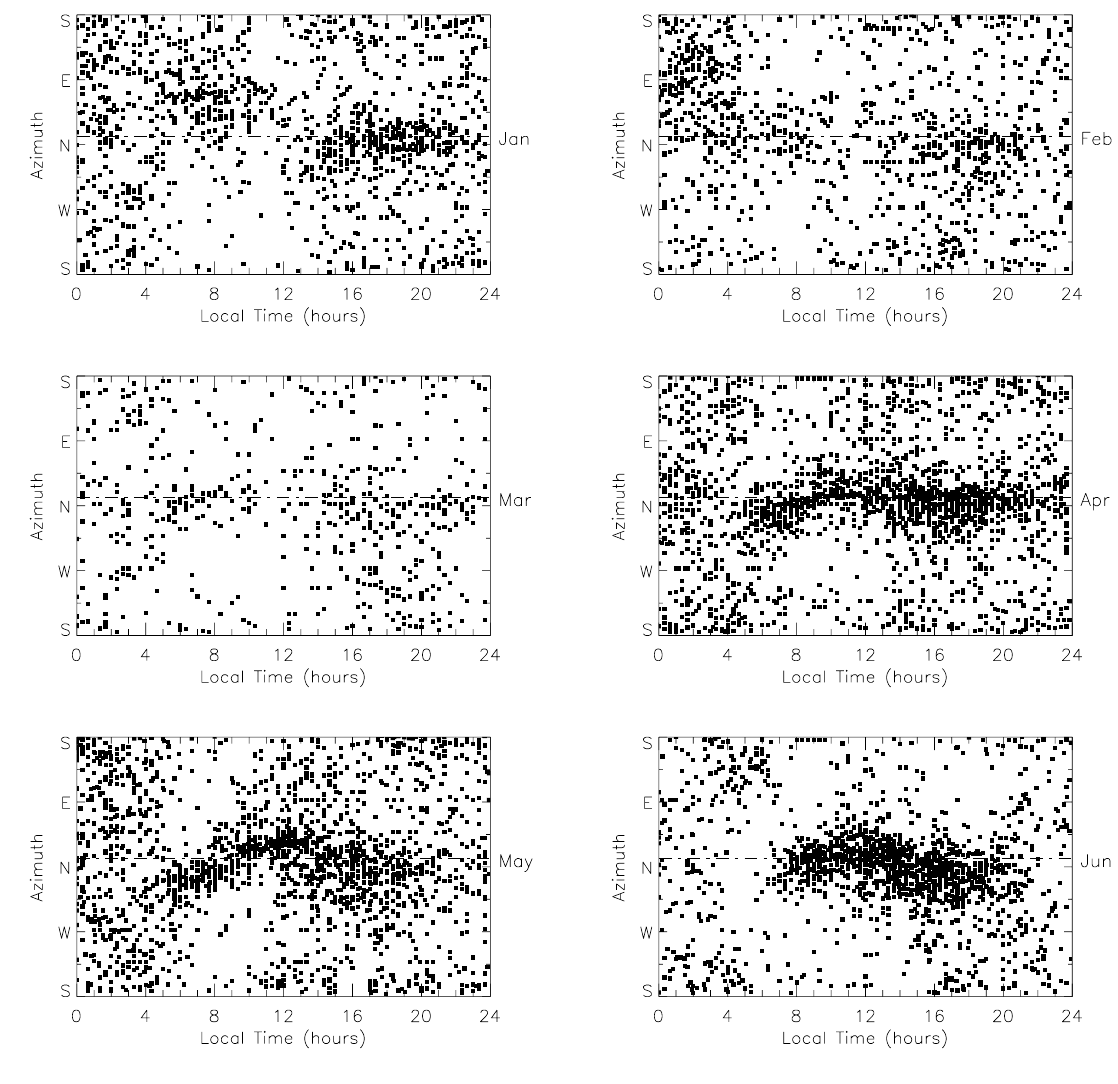
Fig. 11. Diurnal variation of MSTID propagation determined using sea scatter from January to December 2000. The dashed line indicates magnetic